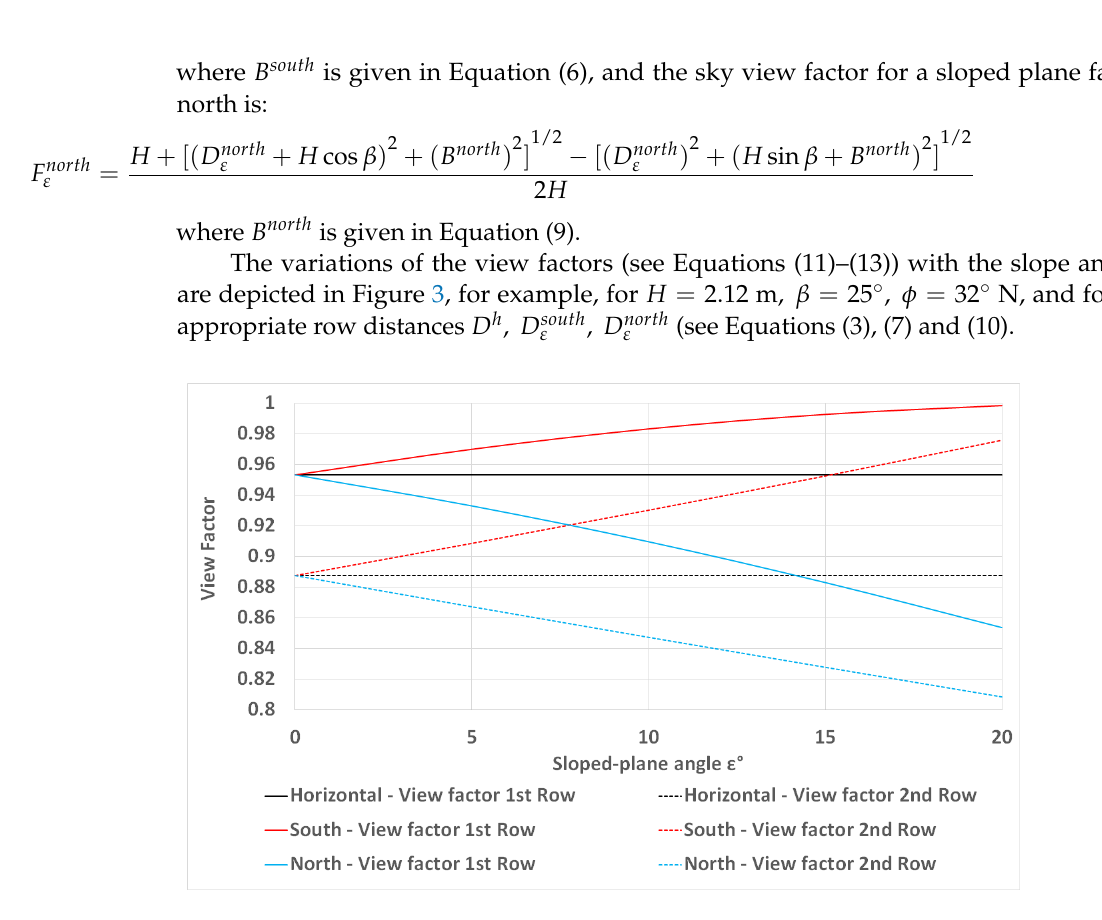
ε 0 25 β= Figure 3. Variation of sky view factors with sloped plane angle ε , β = 25 ◦ , H = 2.12 m, φ = 32 ◦ . Figure 3. Variation of sky view factors with sloped plane angle , 0 2.12 . Percentage of Masking Losses The amount of masking losses is determined by the difference between the annual diffuse incident radiation on the first and on the second row and based on the solar radiation data at Tel Aviv. Figure 4 depicts the ratio of the diffuse radiation between the second and first rows. The ratio pertains to horizontal and sloped-plane ε facing south and north for PV field deployments for H = 2.12 m, L = 40 m, β = 20 ◦ , 25 ◦ , 30 ◦ and for the appropriate row distances D h , D south , D north . An isotropic diffuse radiation model is used ε ε for the calculations. For example, the percentages of masking losses for a horizontal plane are 5.48% ( β = 20 ◦ ), 6.90% ( β = 25 ◦ ) and 8.33% ( β = 30 ◦ ). In terms of energy losses, 5.48% (for β = 20 ◦ and horizontal plane) amounts to a yearly masking loss of 36.7 kWh/m 2 (the horizontal global solar irradiation at the site is 1826 kWh/m 2 /year). For a south sloped-plane ε = 10 ◦ , the masking losses are 3.58%, 5.39% and 7.22%, respectively, and for a north sloped plane, the masking losses are 5.83%, 6.86% and 7.92%, respectively. The results show, as expected, that the masking losses increase with the increase in the collector inclination angle β . The lowest diffuse radiation losses are obtained for deployments on south sloped planes. Actually, the diffuse radiation losses stem from the difference in the view factors of the first and the second collector rows; therefore, the percentage of these losses may be calculated from the sky view factors for the isotropic diffuse radiation